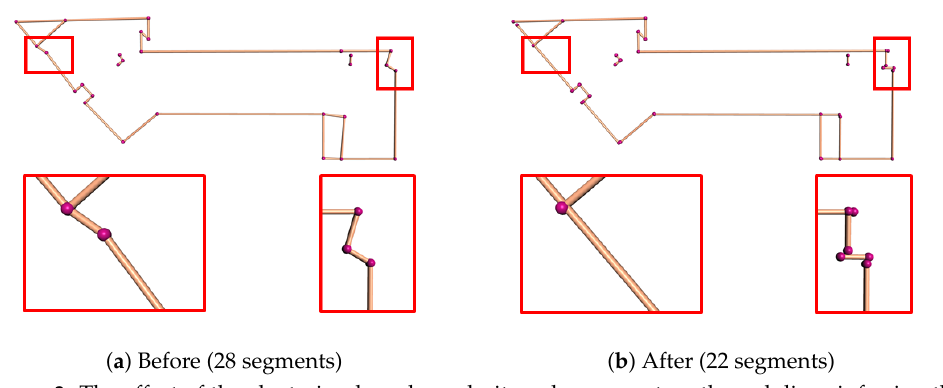
Figure 3. The effect of the clustering-based regularity enhancement on the polylines inferring the vertical walls. ( a ) Before regularity enhancement. ( b ) After regularity